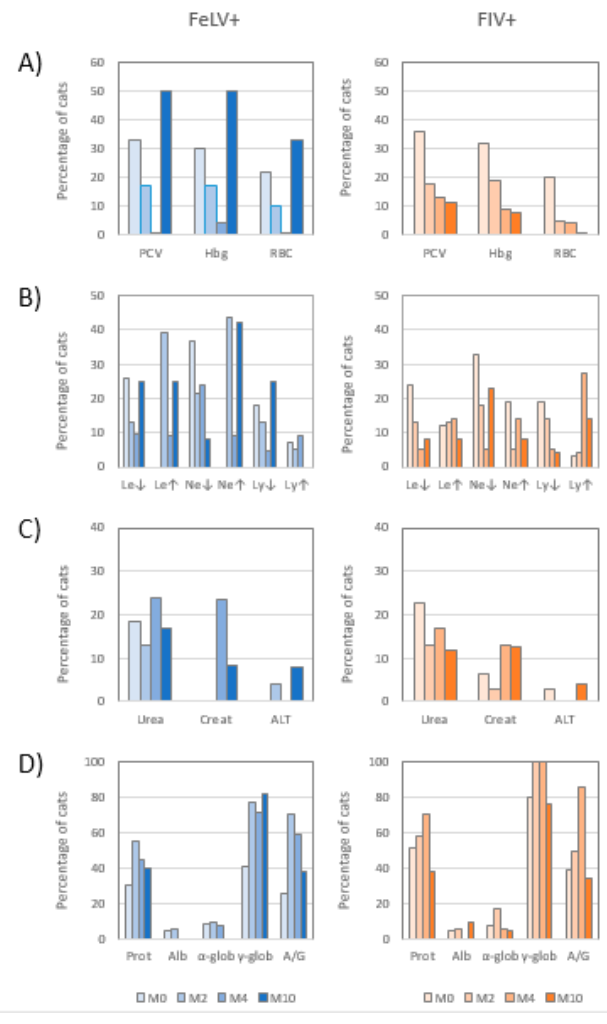
Figure 2. Percentage of FeLV + and FIV + cats treated with rHuIFN- α with altered hemogram ( A ), leukogram ( B ), biochemical profile ( C ), and electrophoretogram ( D ), at each time point of the